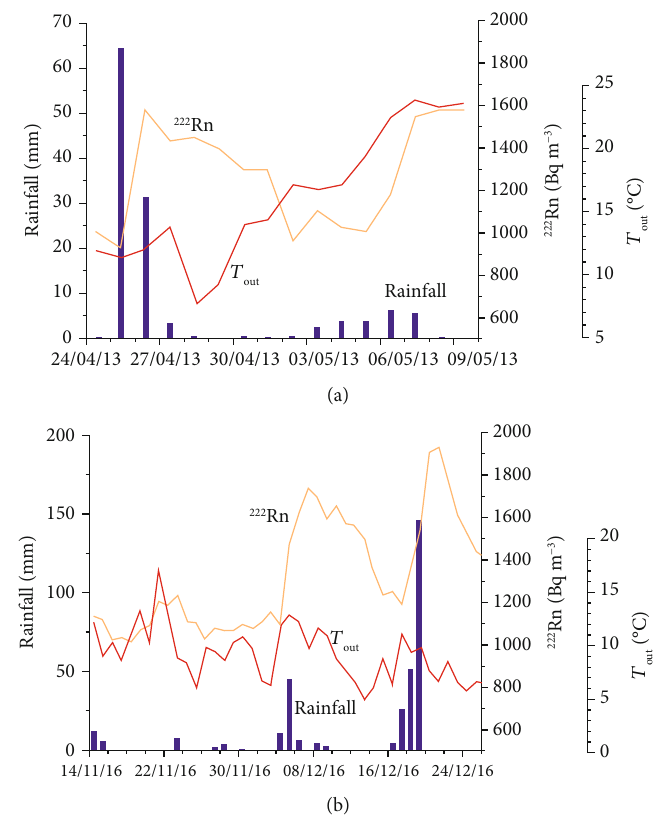
Figure 11: Detail of the increase in 222 Rn concentration during (a) April 2013 and (b) November